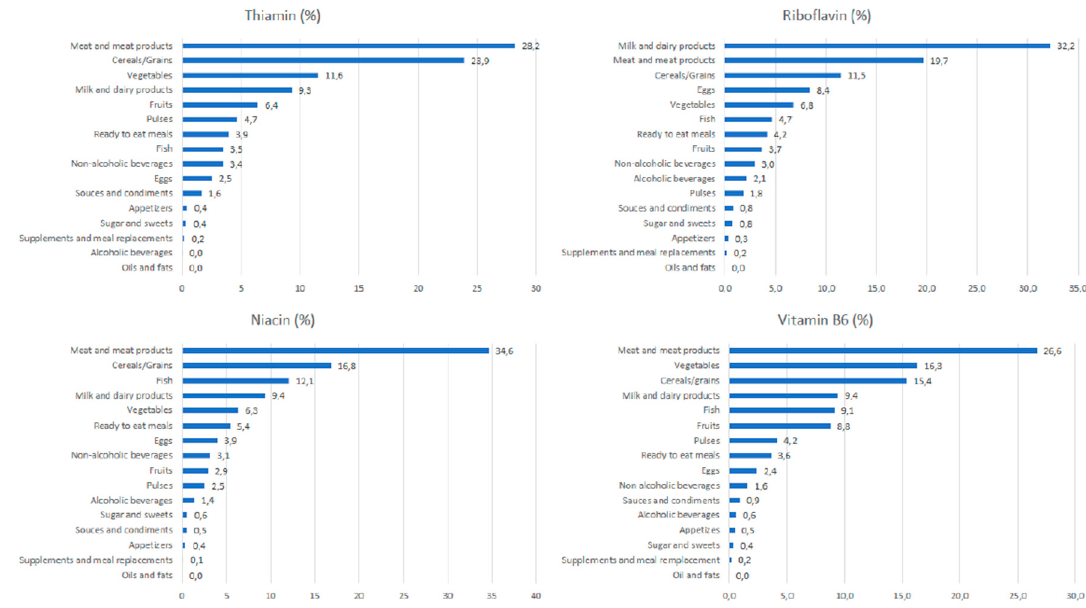
Figure 1. Contribution of food sources to the daily thiamin, riboflavin, niacin vitamins B6 intake in the total ANIBES population.